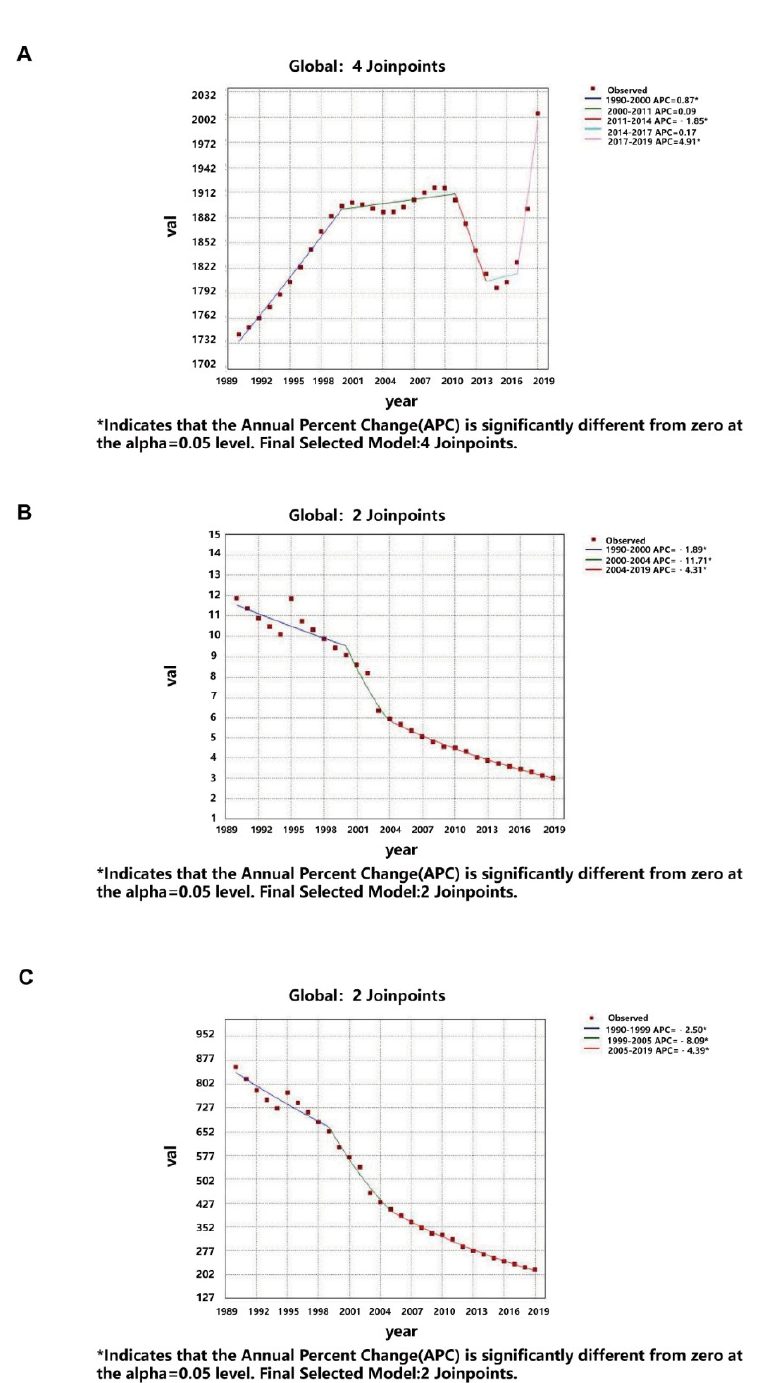
Figure 7. JointPoint regression analysis for protein–energy malnutrition from 1990 to 2019. ( A ) Age-standardized prevalence rate globally; ( B ) Age-standardized death rate globally; ( C ) Age-standardized disability-adjusted life years globally. The prevalence of protein–energy malnutrition increased from 1990 to 2011 globally, and went through a U-shaped curve from 2011 to 2019. The JointPoint of deaths and DALYs decreased between 2000 and 2019.